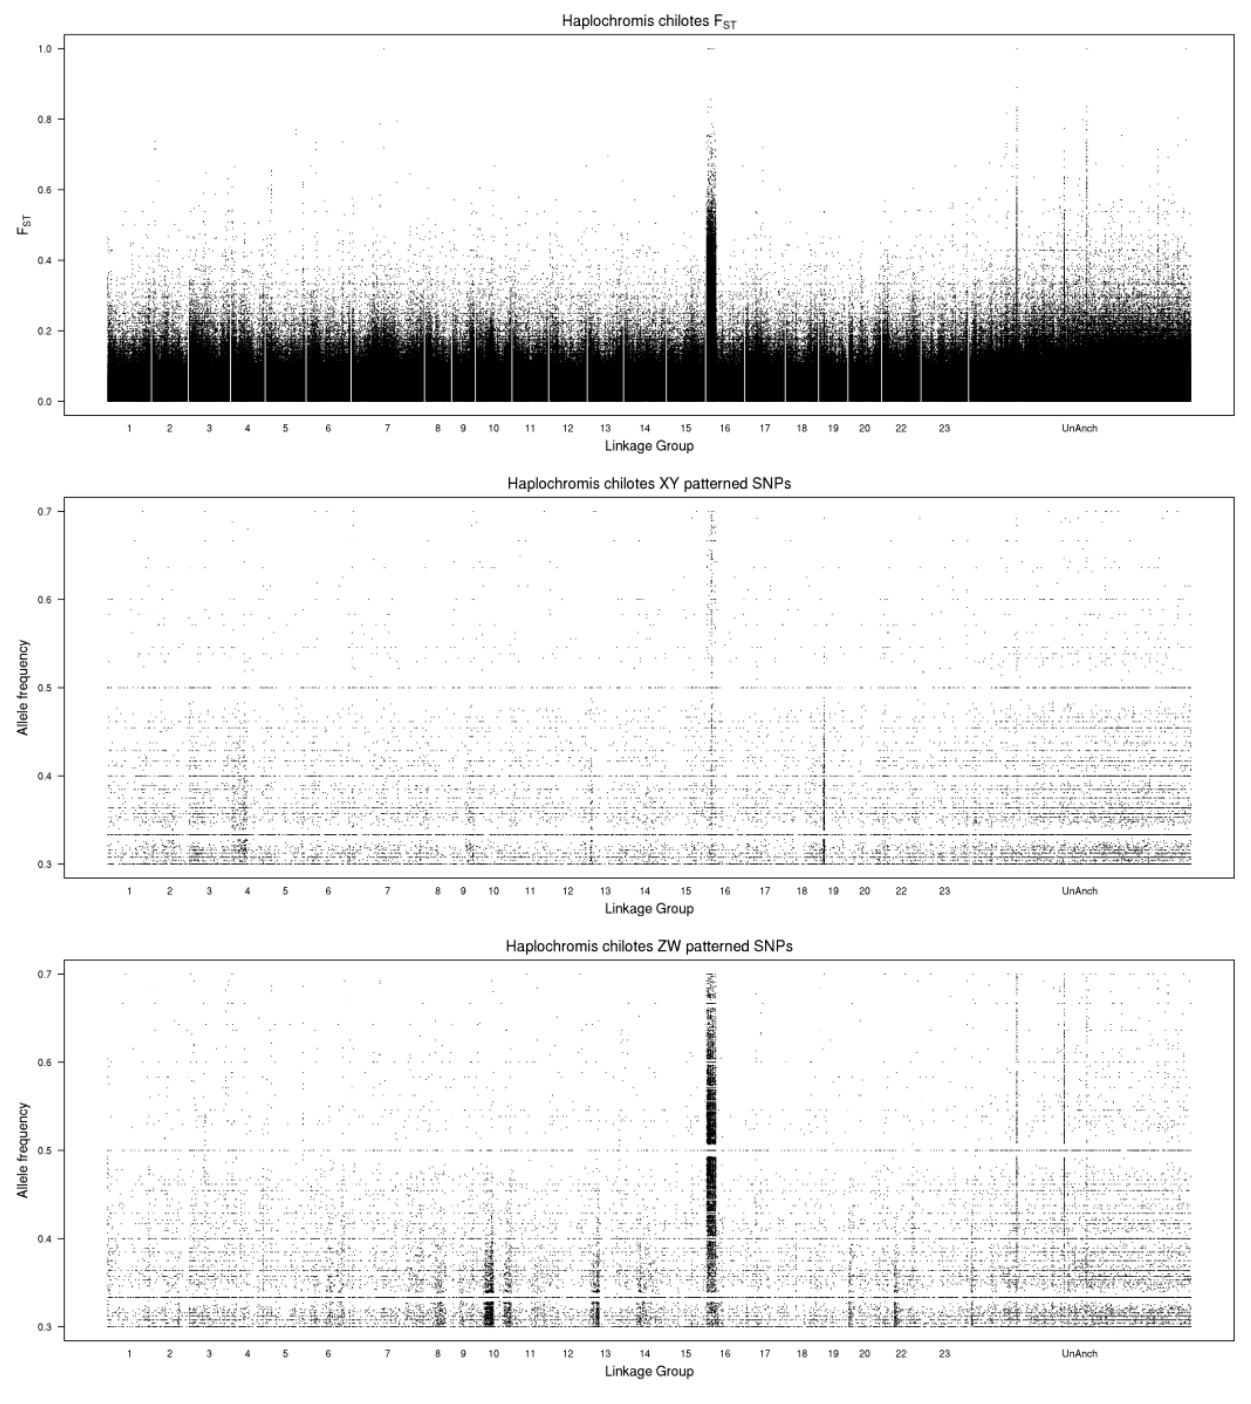
Figure 1. Whole genome plots comparing the male and female pools of Haplochromis chilotes. The top panel shows values for F ST . The middle panel shows the frequency of Y-patterned SNPs in the male pool. The bottom panel shows the frequency of W-patterned SNPs in the female pool. The reference genome is the Maylandia zebra UMD2a assembly.